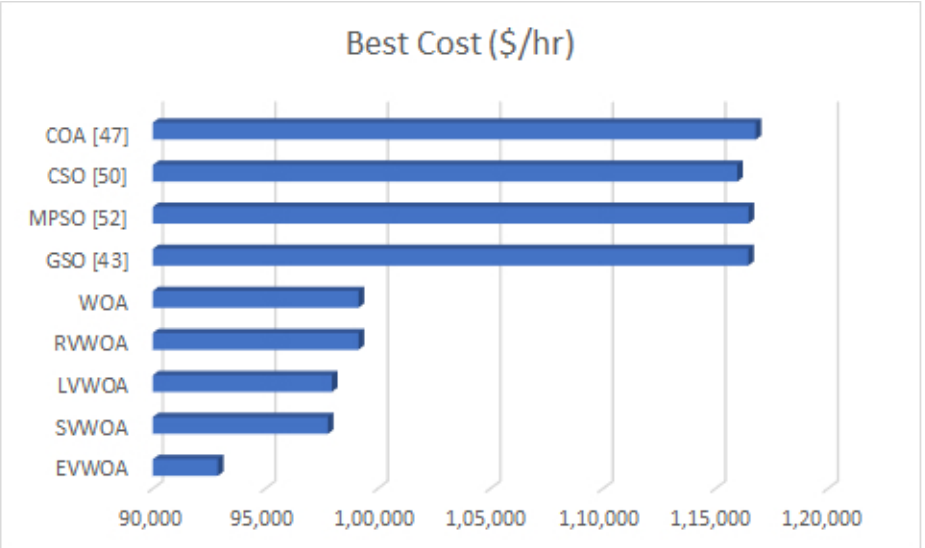
Figure 13. Best Cost Comparison for Case Study